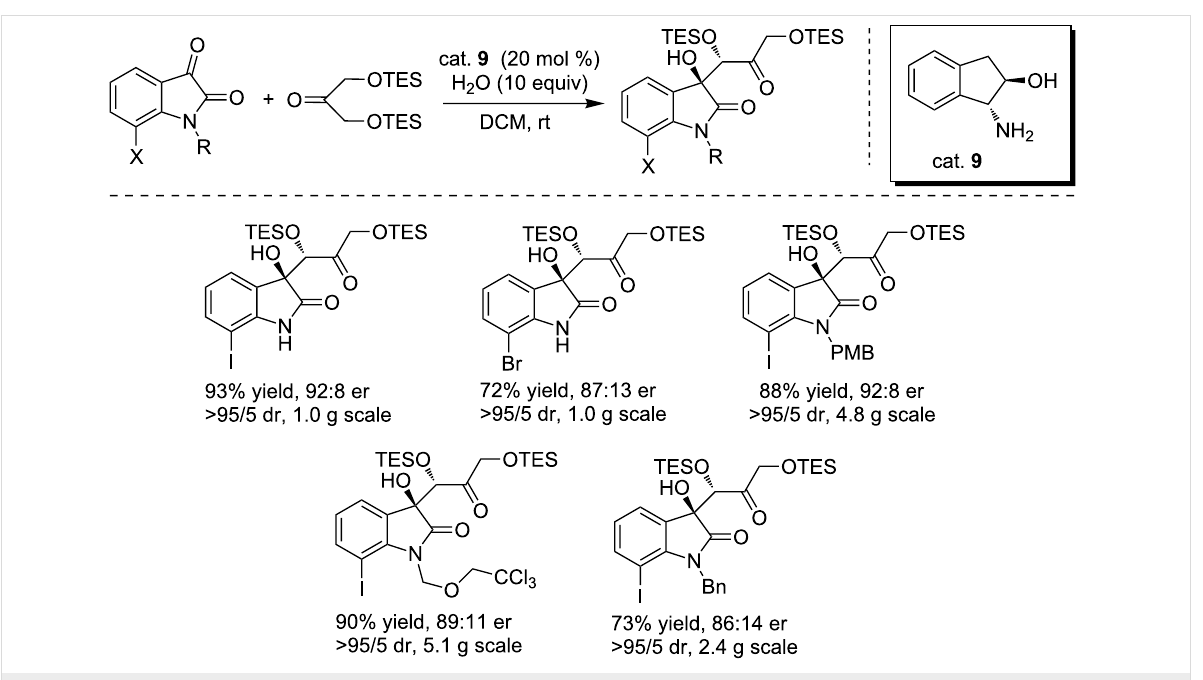
Scheme 22: Aldolization between isatins and dihydroxyacetone derivatives.